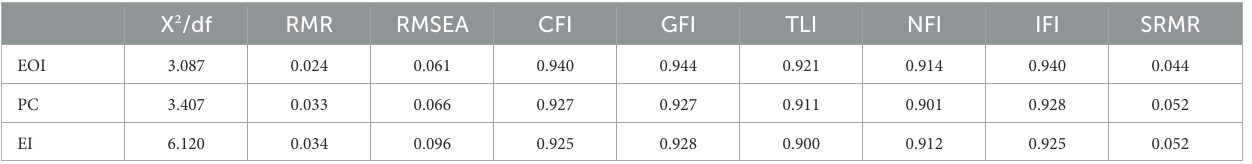
TABLE 1 Measurement model validity.